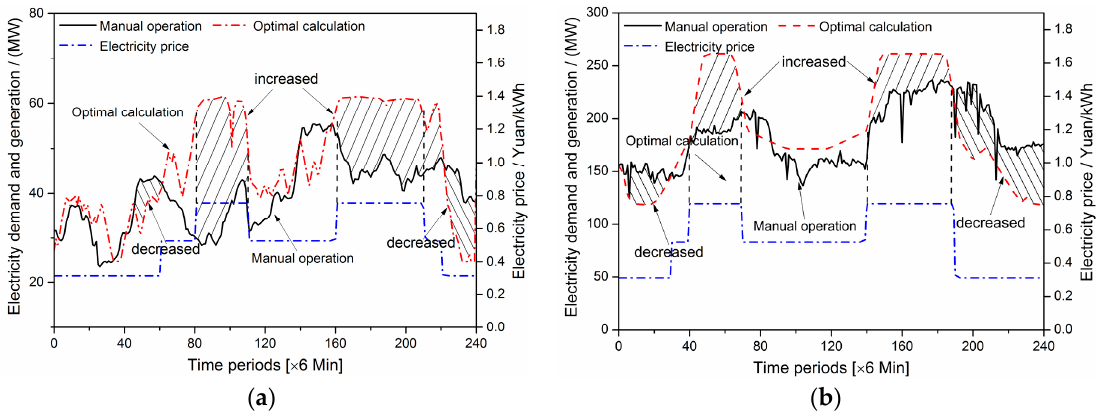
Figure 2. ( a ) Electricity generation of plant A in each period before and after optimization; ( b ) electricity generation of plant B in each period before and after optimization.